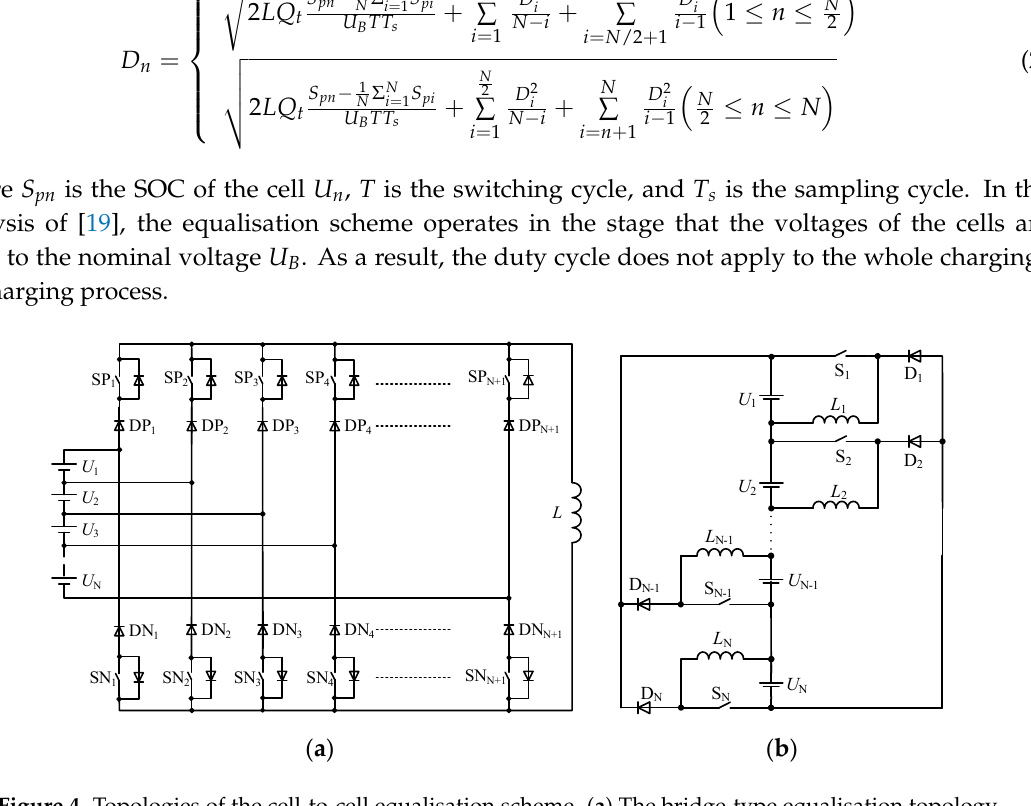
Figure 4. Topologies of the cell ‐ to ‐ cell equalisation scheme. ( a ) The bridge ‐ type equalisation topology. ( b ) The inductor symmetrically ‐ distributed equalisation topology.